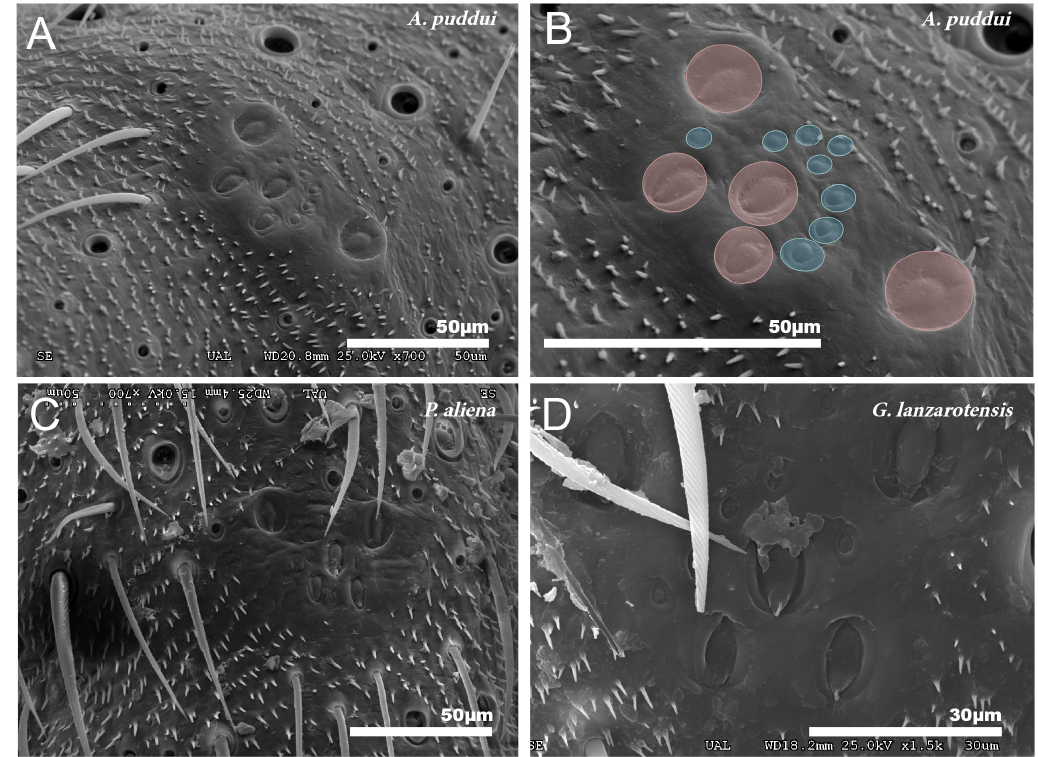
Figure 8. Group of campaniform sensilla. ( A , B ) Group of campaniform sensilla detected in the anterior tibiae of A. puddui . ( C ) Group of campaniform sensilla of P. aliena . ( D ) Group of campaniform sensilla of G. lanzarotensis . These types of structures have been detected in all eight species studied by SEM. The design is similar in all cases. In the detailed image of A. puddui ( B ), different regions were colored to better highlight the different areas. In pink is the area occupied by the five bell-shaped sensilla arranged in “W”. Just next to these five elements, there is a second area (colored in blue) that is occupied by eight smaller papillae.